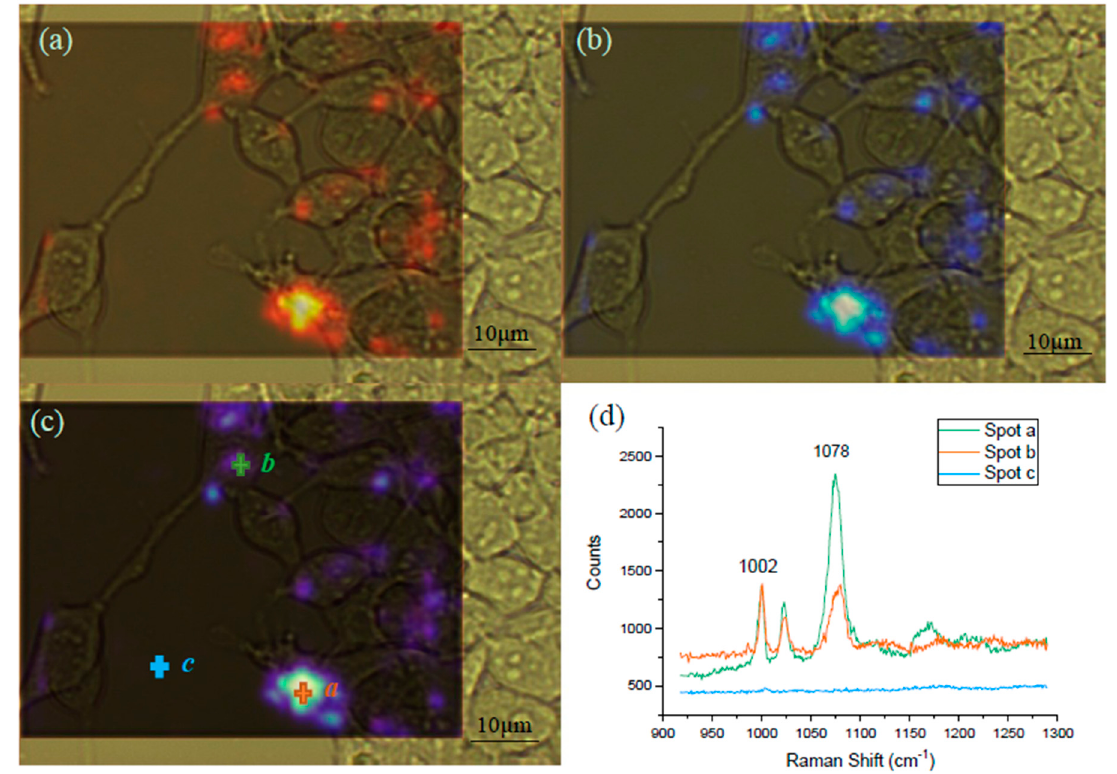
Figure 7. Raman mapping of the HEK293-GPR120 cells at the native cell peak 1002 cm − 1 and the SERS peak 1078 cm − 1 . The framed areas were selected for the mapping of both the 1002 cm − 1 ( a ) and 1078 cm − 1 ( b ) peaks. Combination ( c ) of the spectral images at 1002 cm − 1 ( a ) and 1078 cm − 1 ( b ). The red ( a ) and blue ( b ) color intensities were positively correlated to the peak counts. Spectra from spot a, b, and c ( d ), Scale bar: 10 µm. The mapping spectrum scanning range was from 920 cm − 1 to 1285 cm − 1 , 100% laser power, and 10 s exposure time. LA concentration: 60 µM.